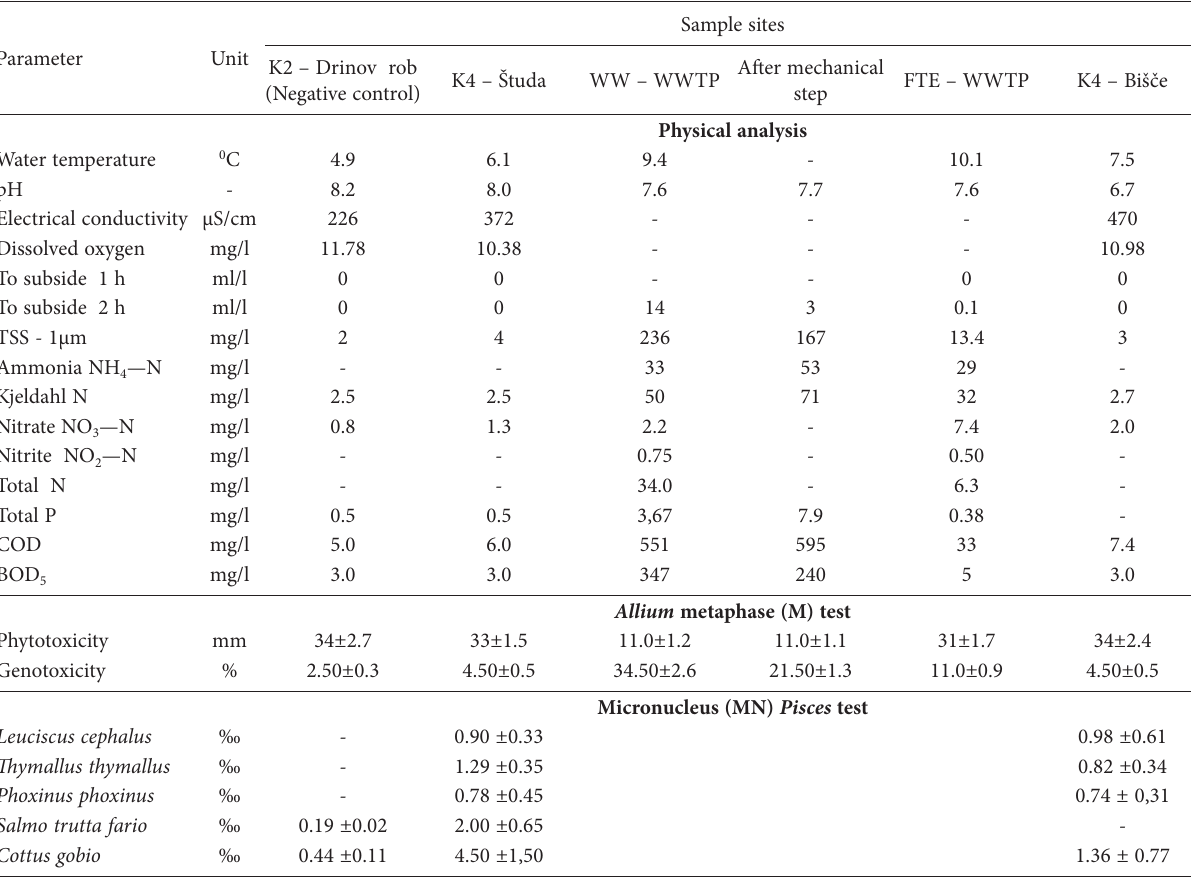
Table 2. United parameters physical quantities;cytological effects of the investigated samples survey – the genotoxicity level (damage to chromosomes) and general toxicity - phytotoxicity (root length inhibition) on the test onion plant A. cepa and Pisces micronuclei (MNi)fre- quencies in peripheral blood erythrocytes of river fish. First sampling February